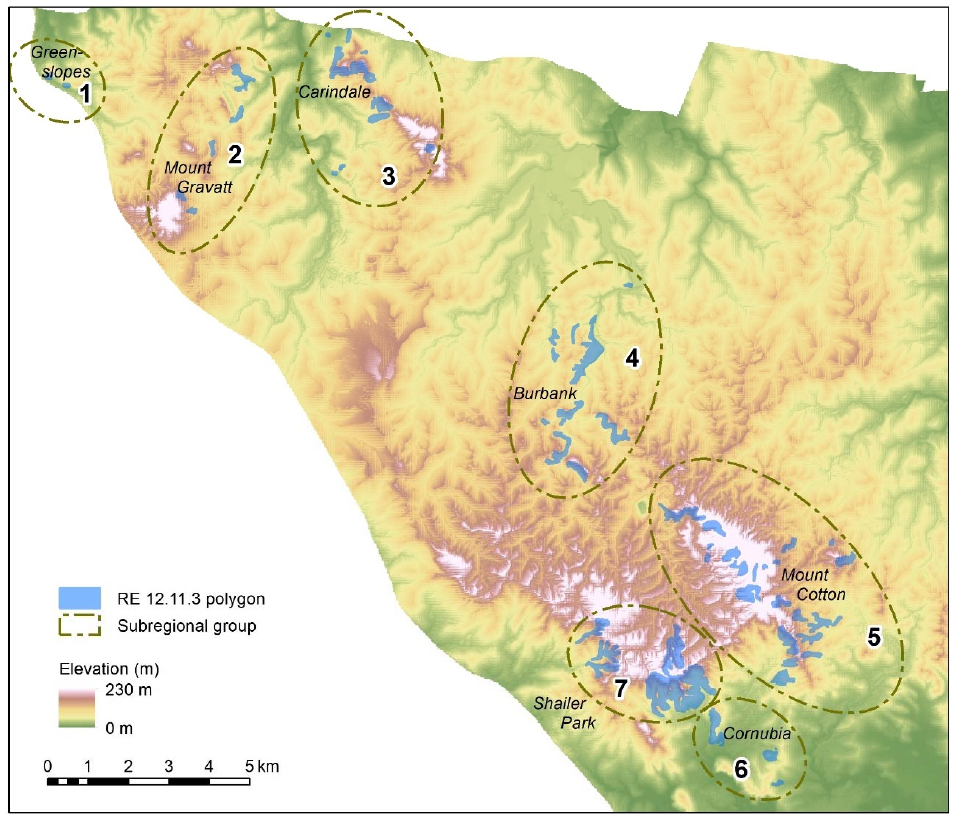
Figure 3. RE 12.11.3 Koala Coast intra-subregional groups, numbered 1–7. We used spatial separation to define most groups and elevation to separate Groups 6 and